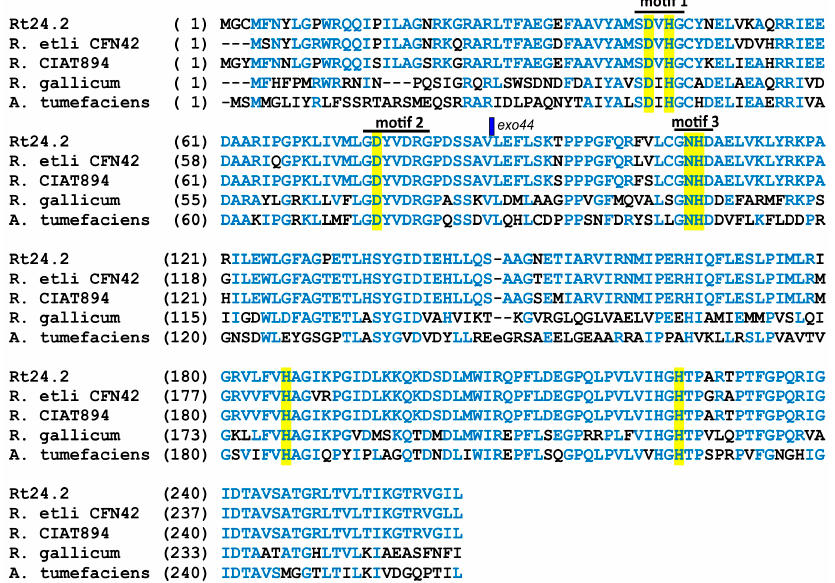
Figure 3. Alignment of amino acid sequences of STPs from R. leguminosarum Rt24.2 (PssZ) (GenBank WP_026230739.1), R. etli CFN42 (ABC92003.1), R. CIAT894 (WP_085738086.1), R. gallicum (WP_040115590.1), and A. tumefaciens (WP_012652475.1). Amino acids that are identical at individual positions in at least three of the analyzed proteins are marked by blue color. The exact point at which the PssZ protein is interrupted because of the exo44 mutation in the pssZ gene (between residues 87 and 88) is marked by a blue rectangle. Motifs 1–3 are designated with black lines, whereas aa residues potentially engaged in metal binding are highlighted in yellow.